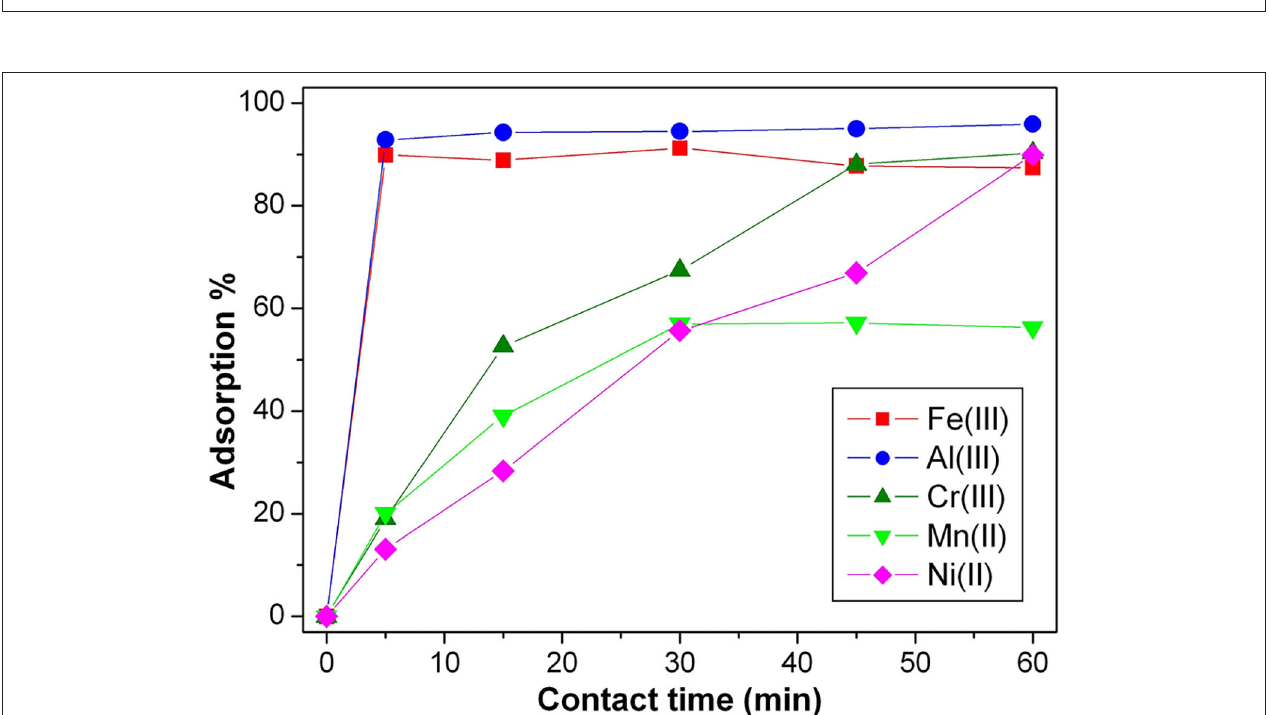
FIGURE 6 | Adsorption kinetics of Fe(III), Al(III), Cr(III), Mn(II), and Ni(II), single ion solutions 1 × 10 − 4 M at pH 5, in presence of SBH-A (800mg L − 1 ).